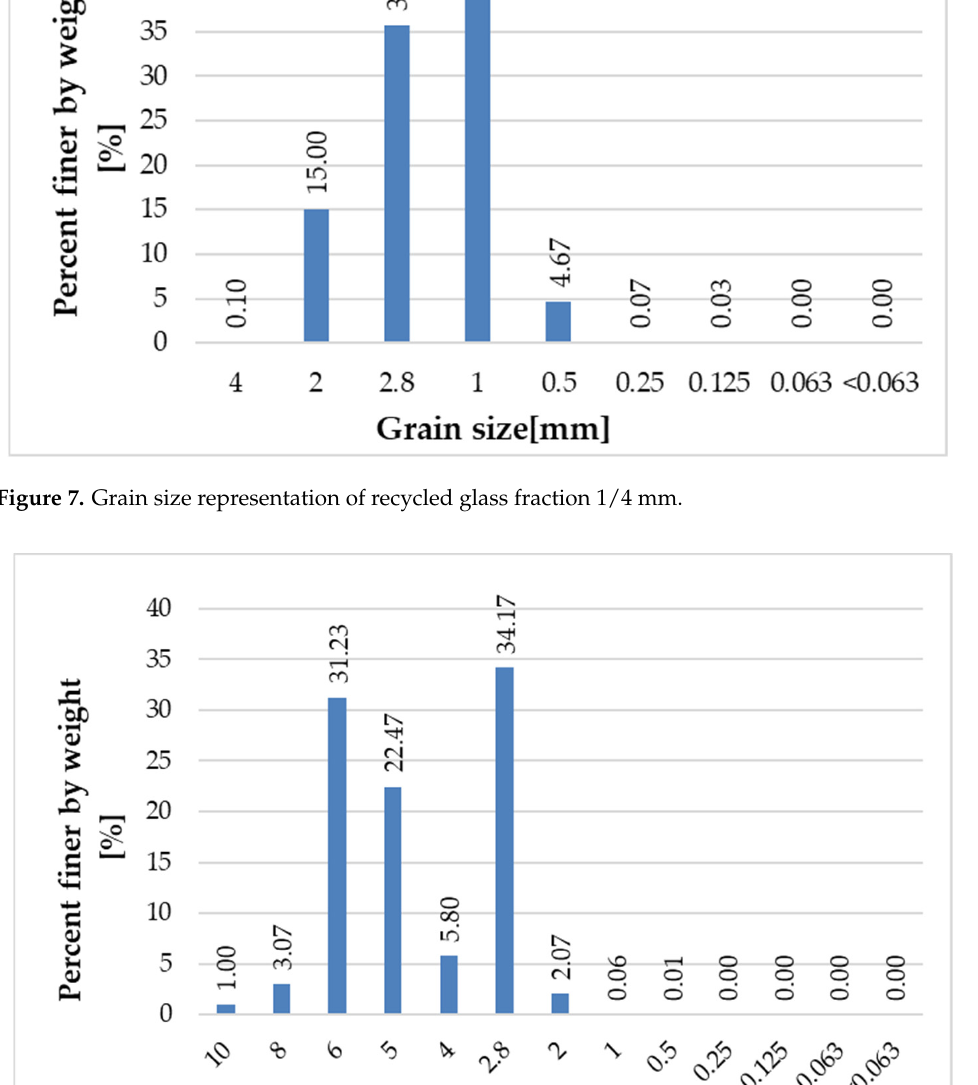
Figure 8. Grain size representation of recycled glass fraction 4/10 mm.